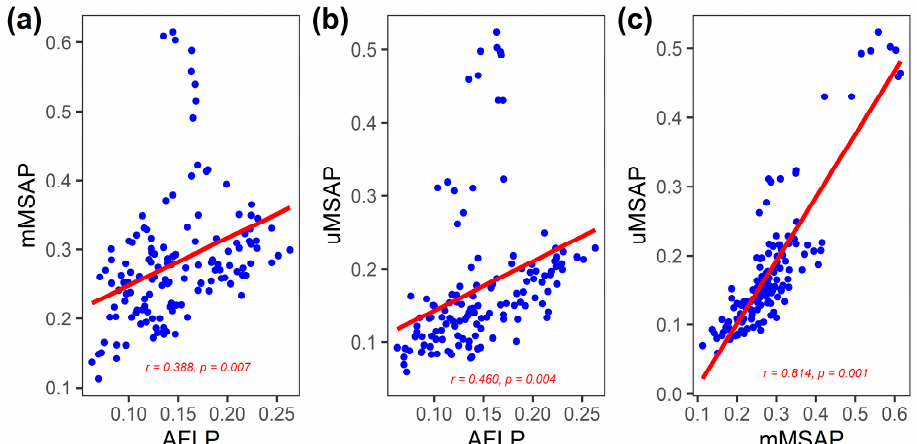
Figure 3. Inter-population relationships between genetic (AFLP) and epigenetic variation (mMSAP and uMSAP) in the 17 Zingiber kawagoii populations. Linear relationships between distance matrices of ( a ) AFLP vs. mMSAP, ( b ) AFLP vs. uMSAP, and ( c ) mMSAP vs. uMSAP are depicted. The Mantel r and p -values for the partial Mantel test are annotated.